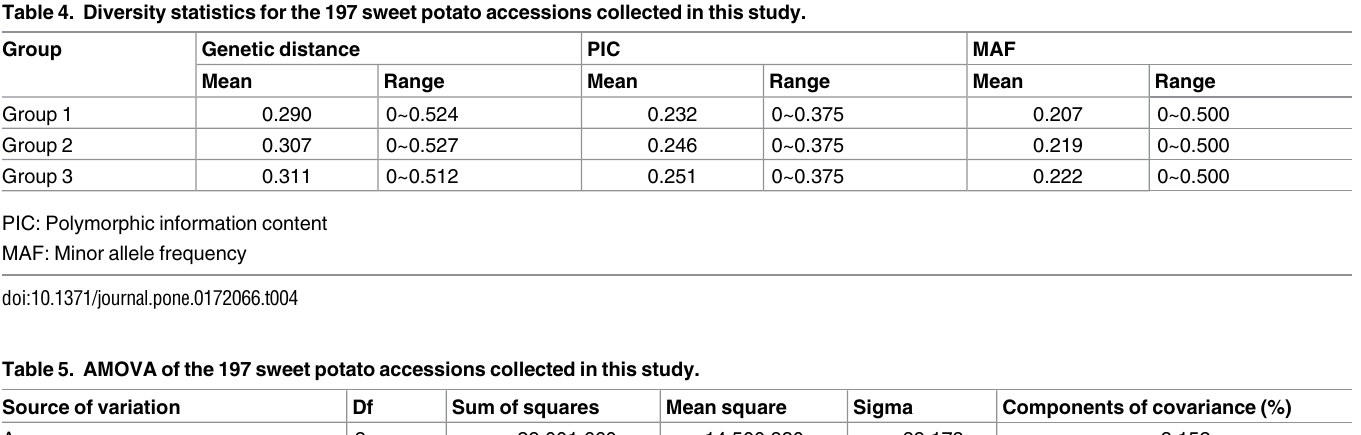
Table 5. AMOVA of the 197 sweet potato accessions collected in this study. Source of variation Among groups